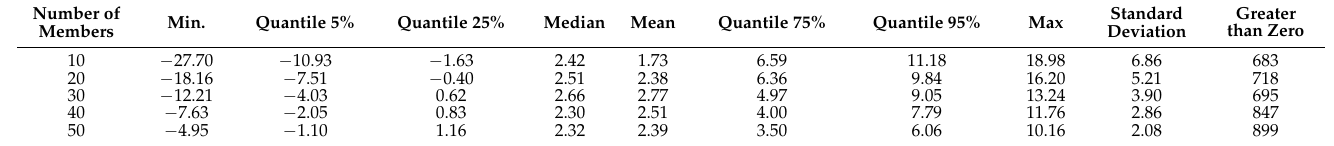
Figure 2. Visualization of the profitability of the energy cooperative by number of members. The statistical results determining the level of profitability as percentages are pre- sented in Table 7. The first column indicates the number of members of the cooperative. The following lines contain statistics corresponding to a cooperative with a certain num- ber of members. The second column contains information on the minimum value of the profitability of the cooperative. This is followed by the 5%, 25%, 50%, 75%, 95% quantiles and the average profitability. The final columns comprise the maximum value, standard deviation and number of observations greater than zero. Table 7. Statistics of the profitability of the cooperative depending on the number of